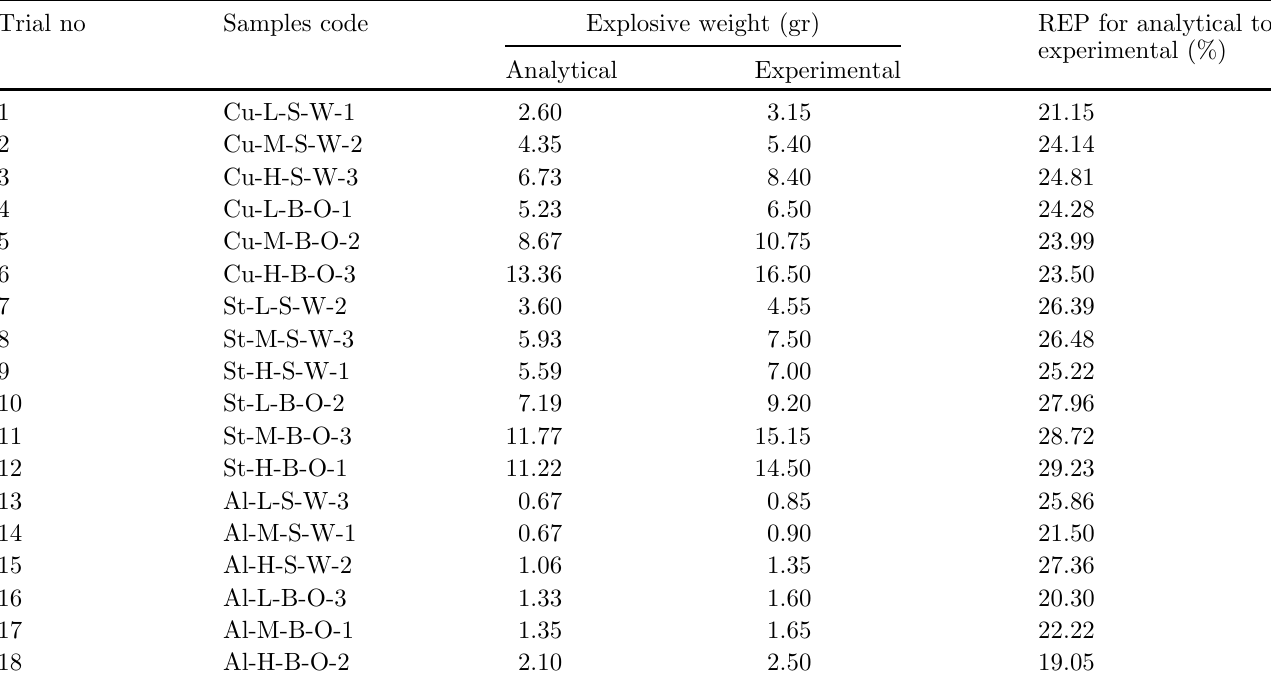
Table 4. REPs of analytical estimated explosive mass in comparison with the experimental results. Trial no Samples code Explosive weight